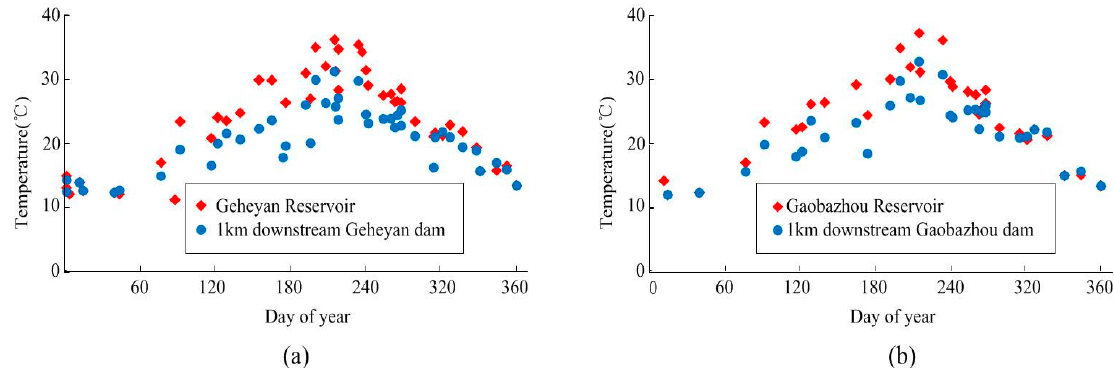
Figure 9. ( a ) Water temperatures in the Geheyan reservoir and 1 km downstream of the Geheyan Dam; ( b ) Water temperatures in the Gaobazhou reservoir and 1 km downstream of the Gaobazhou Dam. Note that the number of water temperature values in each case is different because of the SLC-off problem of Landsat ETM+ images.